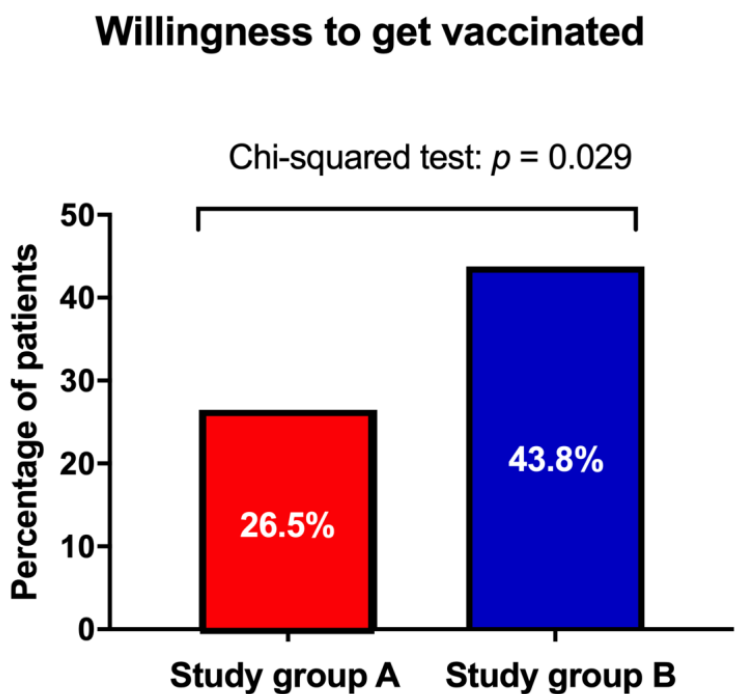
Figure 3. Comparison of the rate of willingness to receive the SARS-CoV-2 vaccination among women in study group A (written briefing only) and study group B (written briefing and oral recommendation) during puerperium. Women in study group B were more likely to receive the vaccination after giving birth than women in study group A ( p = 0.029).